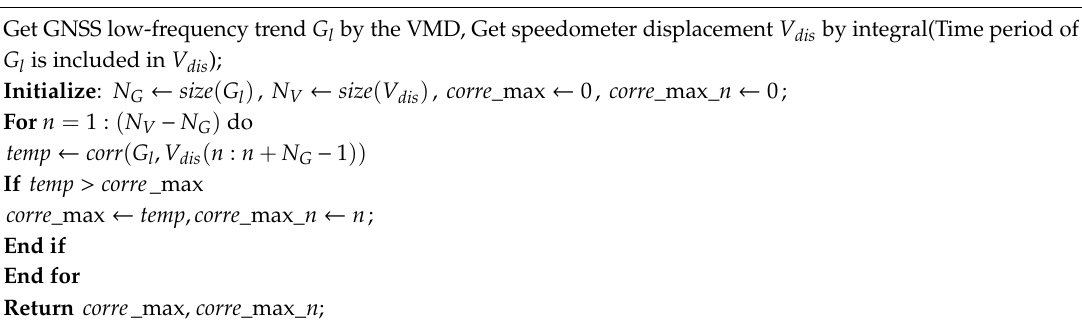
Algorithm 2: Evaluate the Accuracy of Time Synchronization